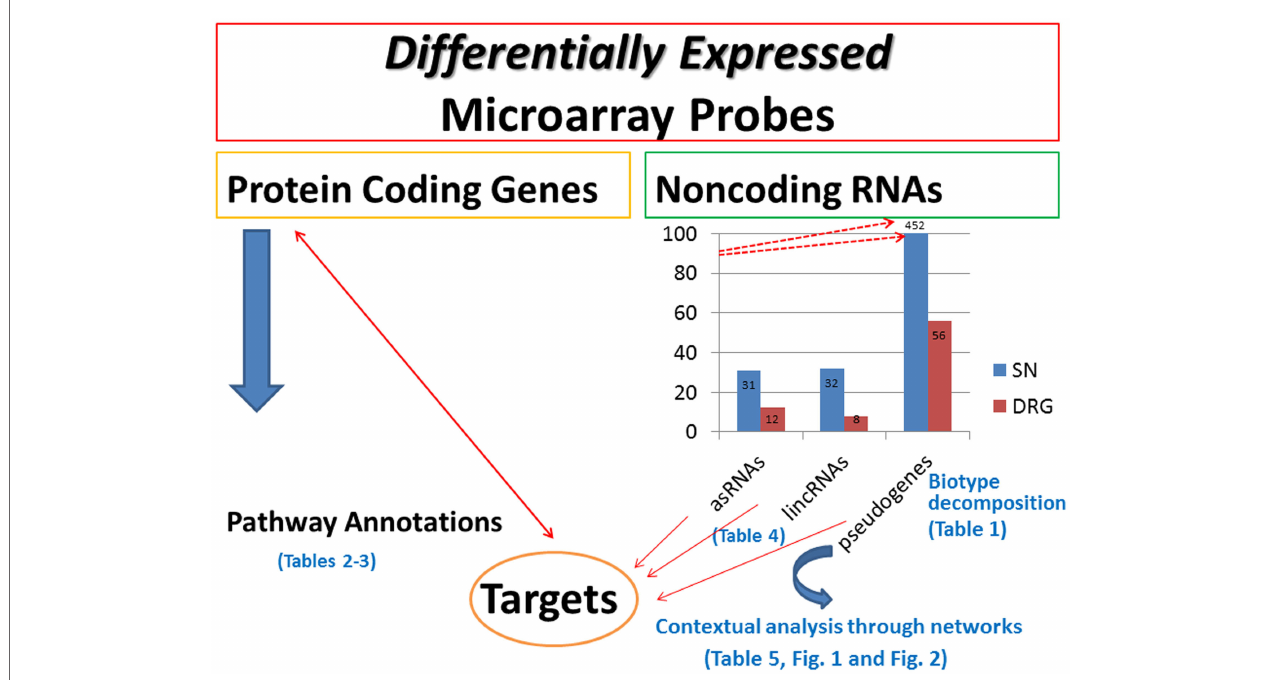
FigUre s1 | Protein–protein interactions for pseudogene targets for Drg . FigUre s2 | Protein–protein interactions for pseudogene targets for sn . TaBle s1 | Parent protein-coding targets classification of transcription factor, kinase, and receptors. TaBle s2 | Pseudogenes and parental protein-coding genes in Drg. TaBle s3 | Pseudogenes and parental protein-coding genes in sn. TaBle s4 | Differentially expressed pseudogenes and parental protein- coding genes in Drg. TaBle s5 | Differentially expressed pseudogenes and parental protein- coding genes in sn. TaBle s6 | enriched terms and full details for pathway analysis in sn. TaBle s7 | enriched terms and full details for pathway analysis in Drg. TaBle s8 | Probe sets and genes. TaBle s9 | cross-references for Table 2